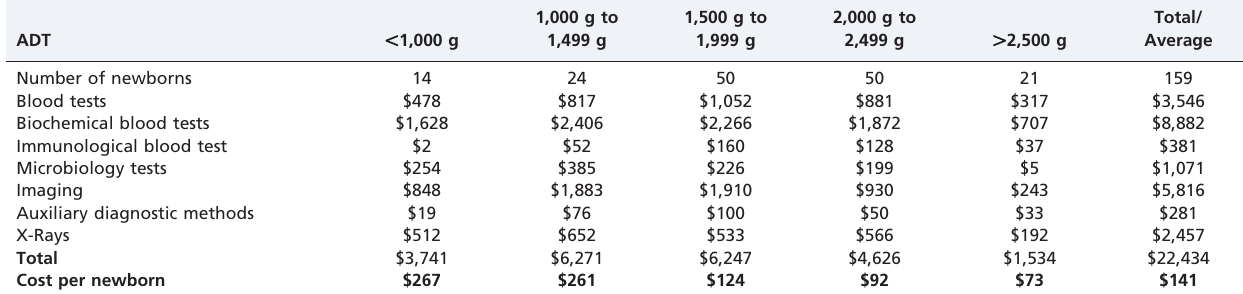
Table 5 - Costs for blood products used to treat premature newborns. BLOOD PRODUCTS Number of newborns